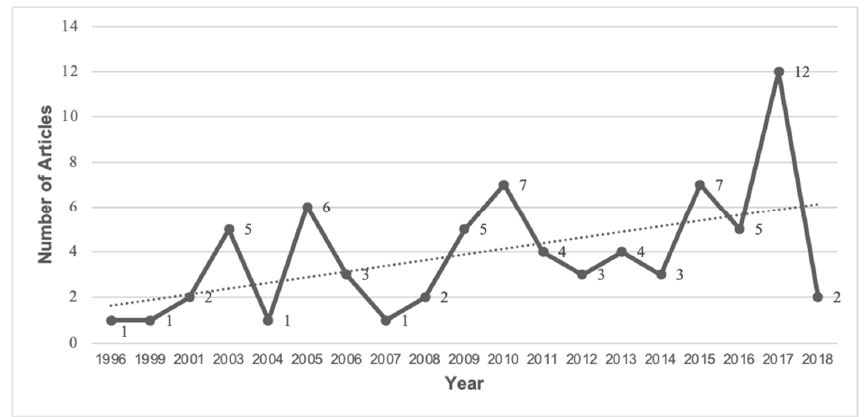
Figure 4. Article frequency by year .